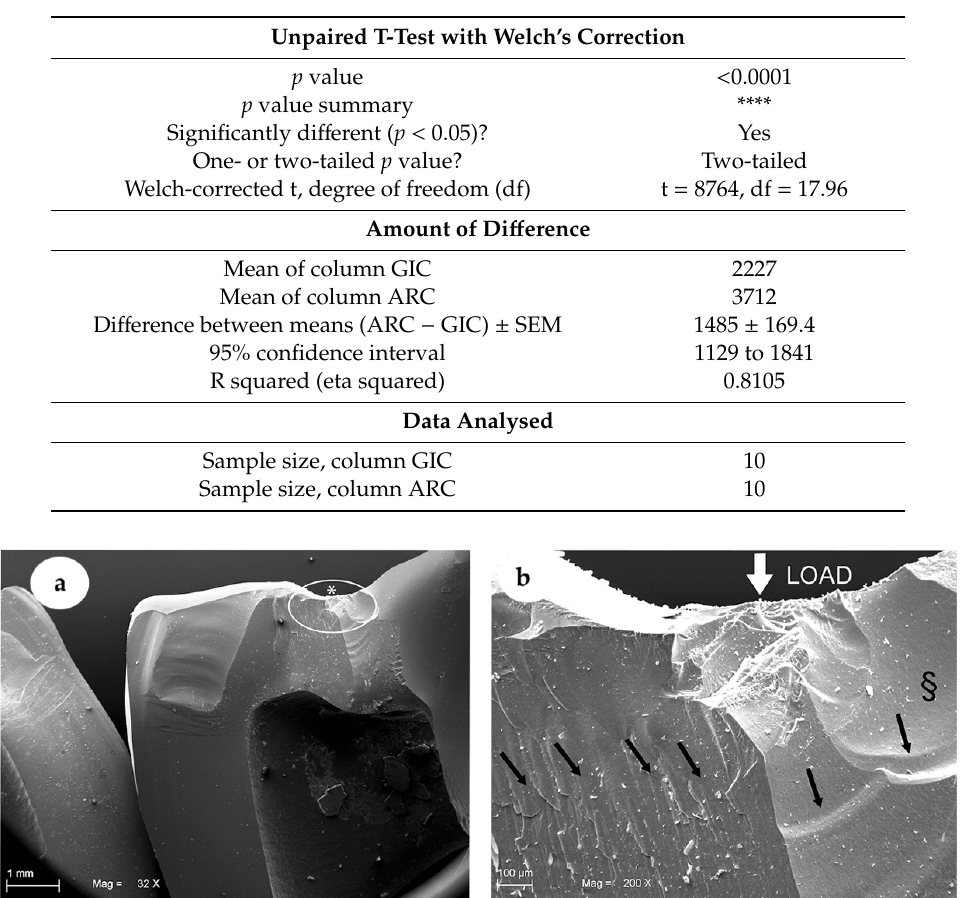
Figure 2. Graphical representation of fracture toughness values. Table 1. Statistical analysis of fracture toughness values. Samples showed a statistically significant di ff erence between the groups ( p < 0.05).